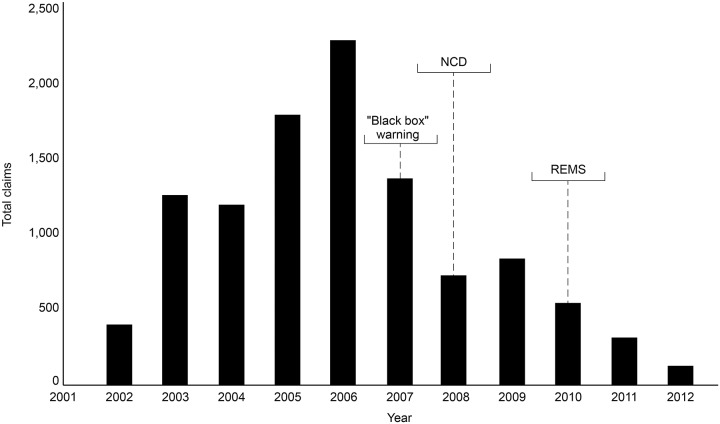
South Carolina Medicaid claim data (2002–2012). Reductions in the number of claims for ESAs were observed over the period 2006–2012, indicating the “black box” warning resulted in reductions in ESA use. ESA, erythropoiesis-stimulating agent; NCD, National Coverage Determination; REMS, Risk Evaluation and Mitigation Strategy.